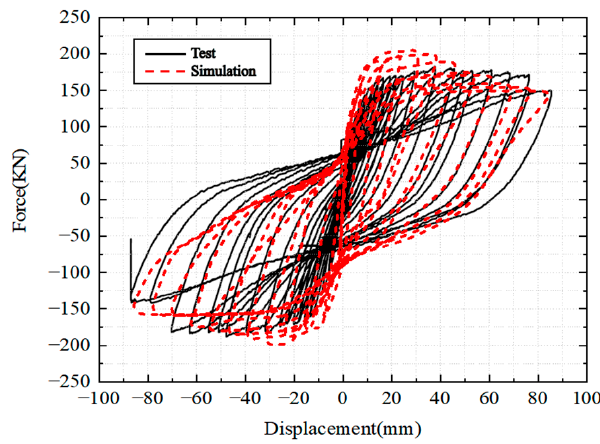
Figure 9. Numerical vs. experimental hysteretic curves.